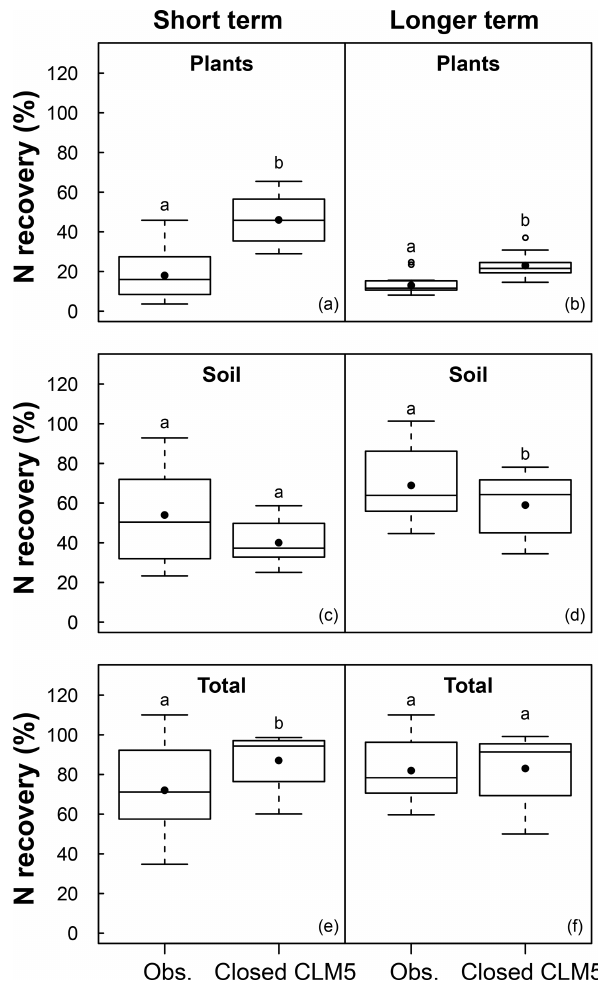
Figure 3. Boxplot showing the mean (filled dot), median (horizon- tal line), 1st quartile, and 3rd quartile of N recovery (%) in the short term ( < 3 years) and long term ( > 3 years) from 15 N experiments with available data (Obs) and model simulations using a closed N cycle (Closed CLM5). Field and modeled data are an aggregate of values from both plant functional types (PFTs) and all N fertiliza- tion or ambient conditions. Whiskers extend to the minimum and maximum N recoveries that are not outliers, which are represented by open circles. Variation in observations occurs from differences measured across sites; variation in the model data occurs from dif- ferences estimated by CLM5 across modeled sites. Different letters indicate groups that are statistically different ( p < 0 .